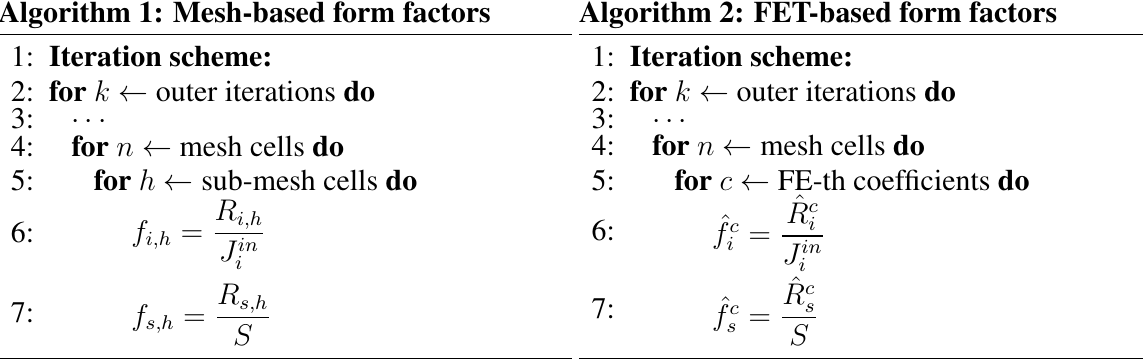
Algorithm 1: Mesh-based form factors Algorithm 2: FET-based form factors